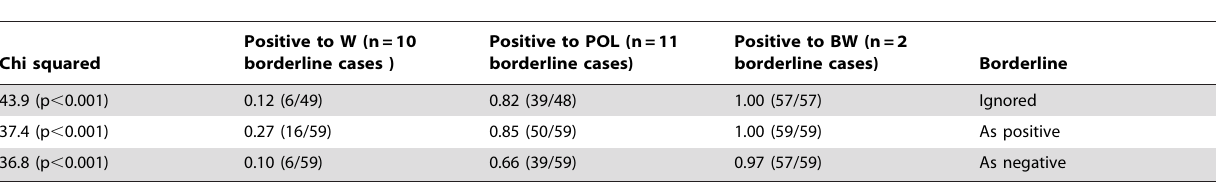
The proportion of positive optomotor responses (N=59) to the control, polarized stripes and black-and-white stripes patterns (W, POL and BW; respectively), with different options of considering borderline cases (in which it was hard to decide whether the response was positive or negative). Ratios of fish responding with actual numbers are given in parenthesis. Chi-squared and p-values pertain to a test for the equality of proportions (proportions test); testing the null hypothesis that the probability of responding positively to POL is equal to the expected by chance (W).